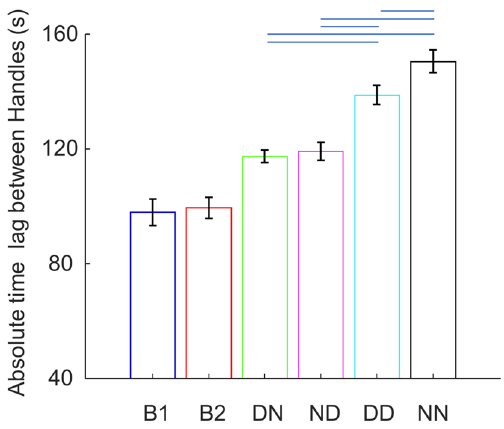
Figure 4. Time lag between handle movement velocities. Absolute time lag between handle vertical movement velocities identified by peak positive cross-correlation. Conditions joined by the twol ends of the blue horizontal lines are statistically